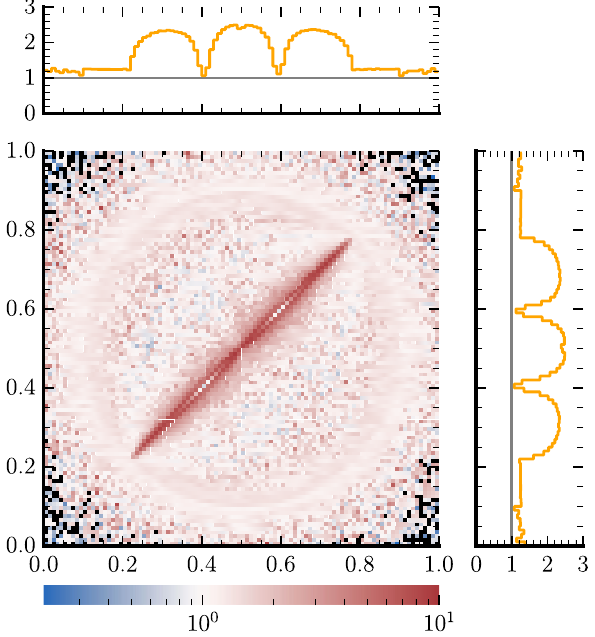
Fig. 8 The ratio of the target function of the two-dimensional toy example and the probability density function of PolyChord using a non-uniform prior distribution. Black histogram bins have not been filled by any data due to limited sample